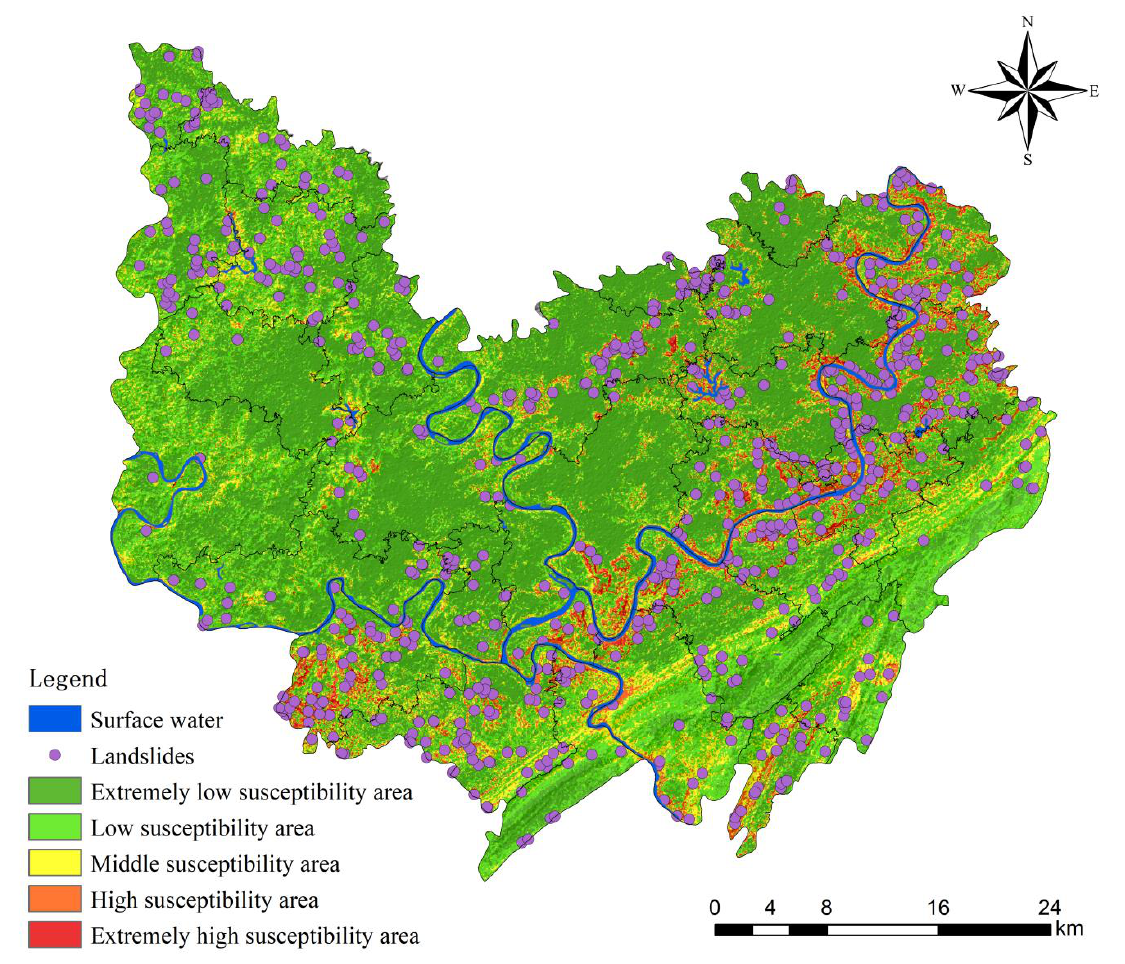
Figure 5. Landslide susceptibility zoning in Hechuan District. Table 7. Statistical table of landslide susceptibility classification.